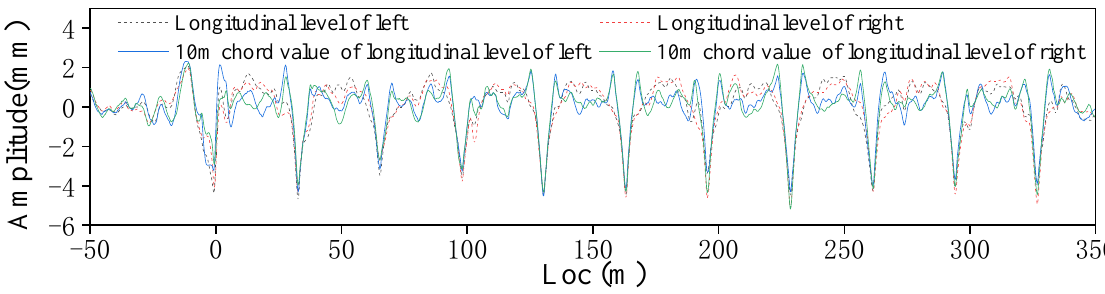
Figure 13. Track longitudinal level and times.